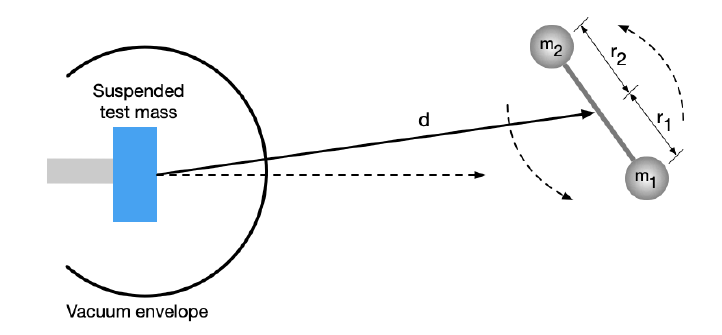
Figure 2. Schematic diagram of a gravity gradient calibrator, commonly referred to as a Newtonian or Gravity calibrator, located near a suspended test